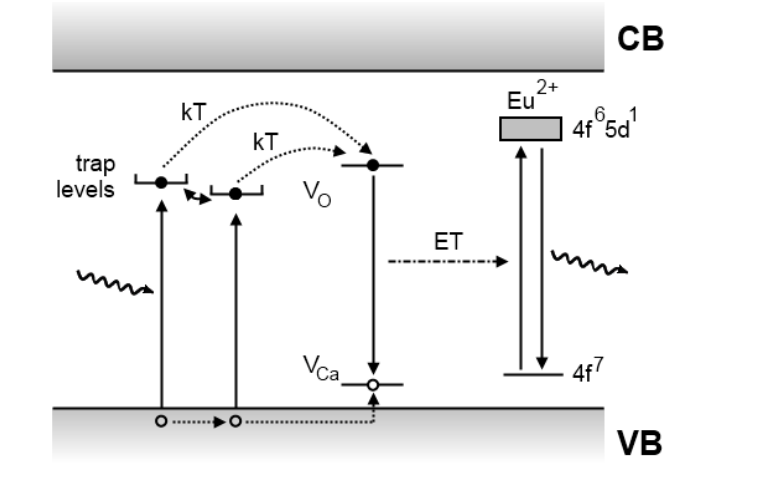
Figure 8. Persistent luminescence mechanism proposed by Aitasalo et al . for CaAl O :Eu 2+ ,Dy 3+ 2 4